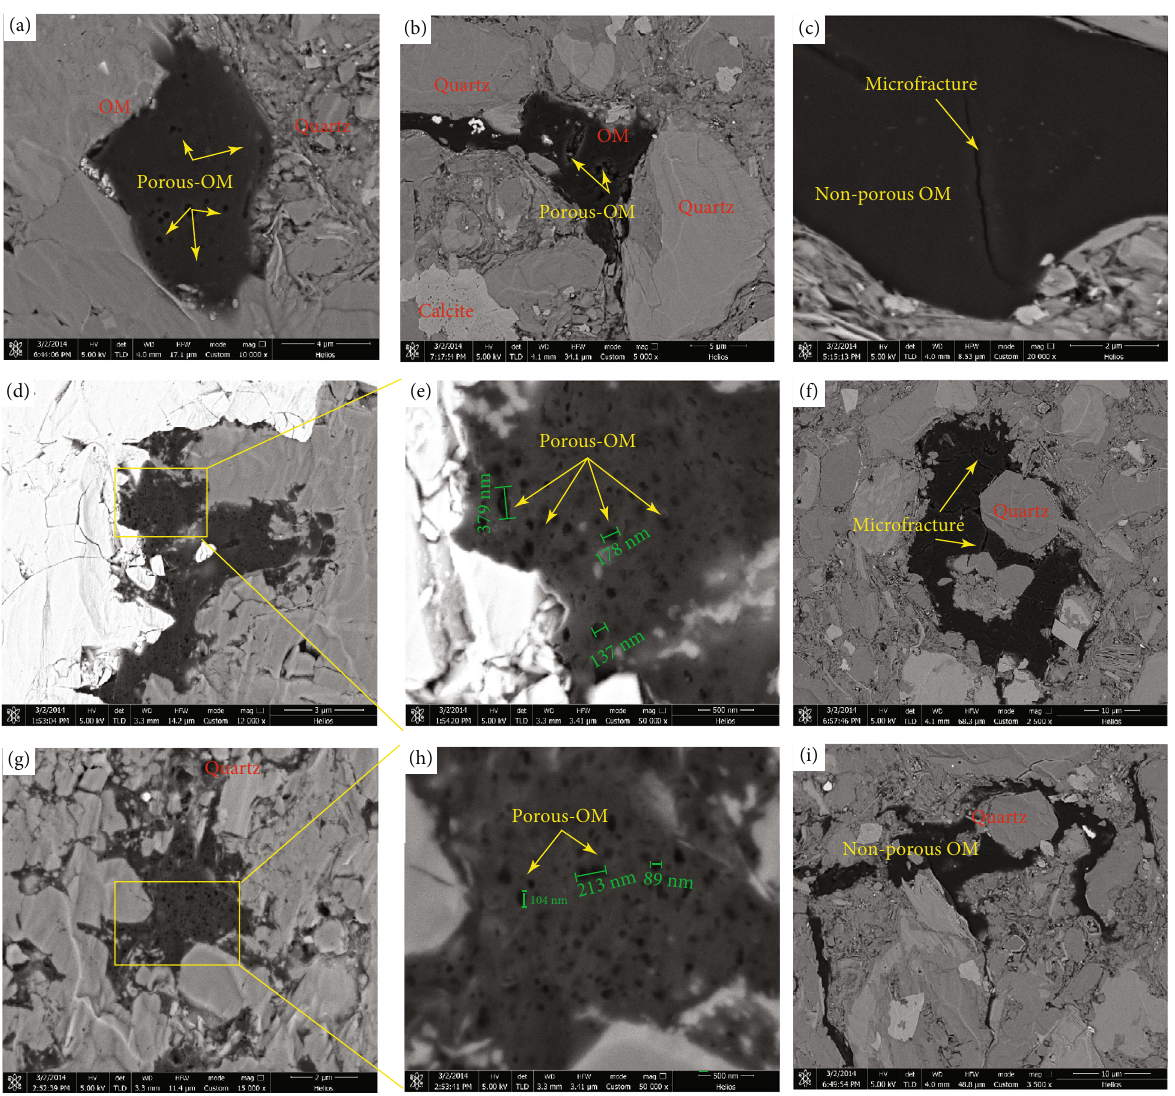
Figure 5: The SEM images of OM pores from MS and SM lithofacies Chang 7 lacustrine sample. (a, b) Porous OM- fi lled residual space of rigid grains (sample ID: YY5-3, 1437.9 m; YY7-1, 1150.3m). (c) Microfractures separating organic matter with smooth edge (sample ID: YY9-1, 1663.4m). (d) Porous OM with gas bubble shape pores among the particles (sample ID: YY13-4, 1360.1 m). (e) The expanded horizon of the image of (d). (f) Zigzagged with microcracks in the OM particles (sample ID: YY5-1, 1450.2m). (g) Porous OM with irregular fi gures among particles (sample ID: YY4-2, 1532.2m). (h) The expanded horizon of the image of (g). (i) Nonporous OM particle squeezed into mineral pores (sample ID: YY12-1,